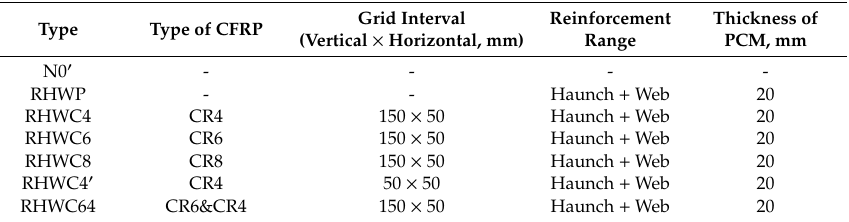
Table 5. Details of the beam specimens of Series B.